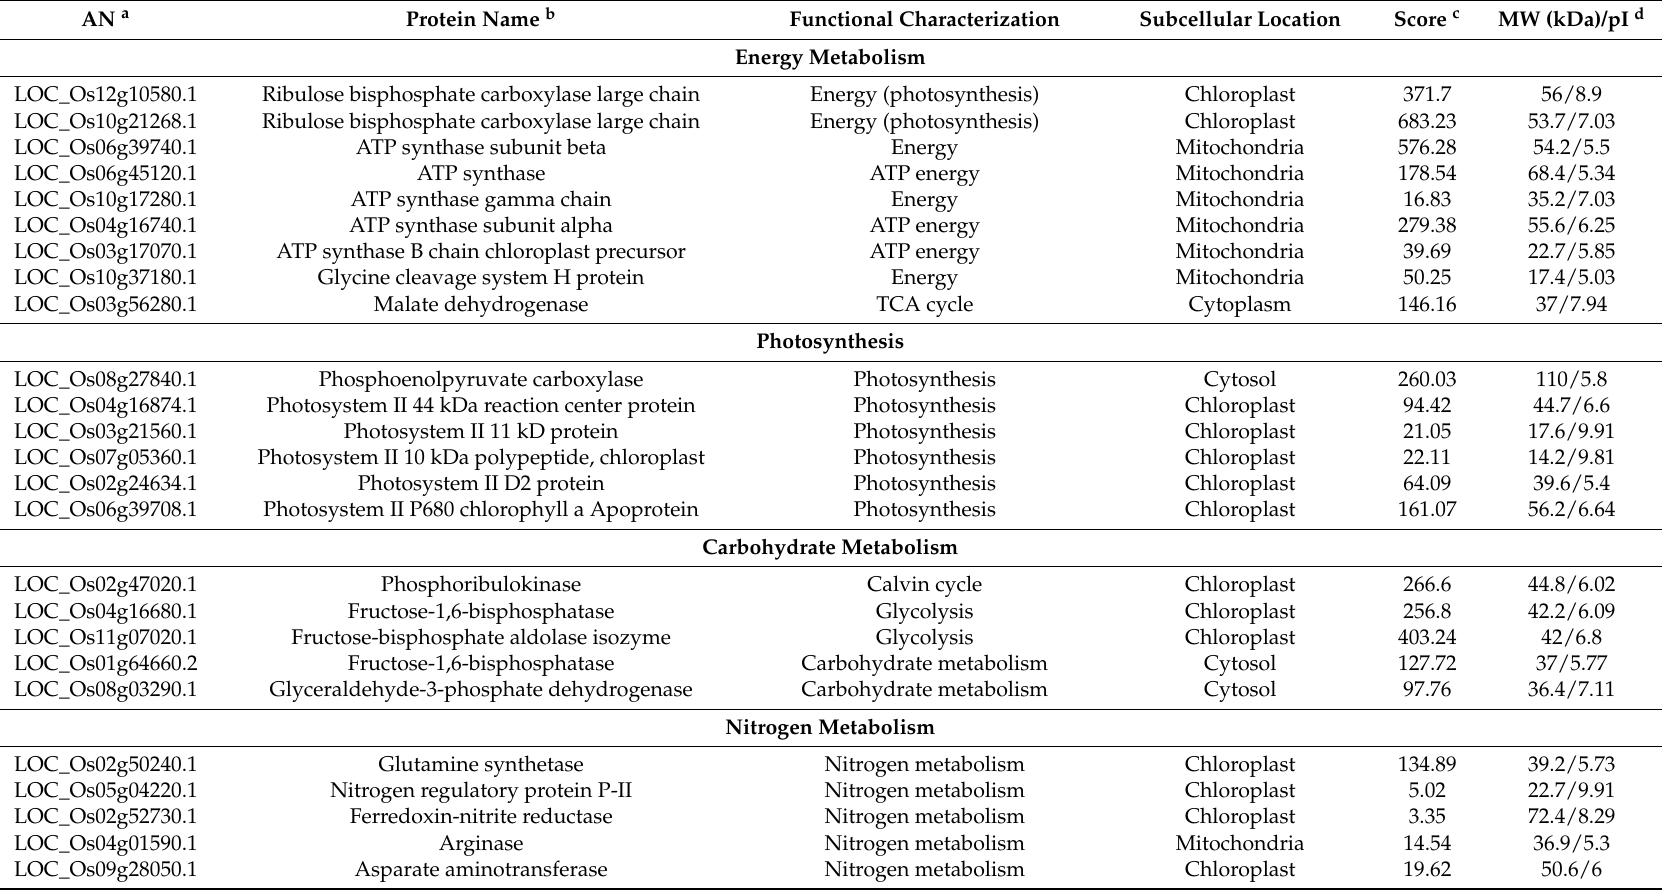
Table 2. LC-MS/MS analysis of the Co-immunoprecipitation of PP2C9TL